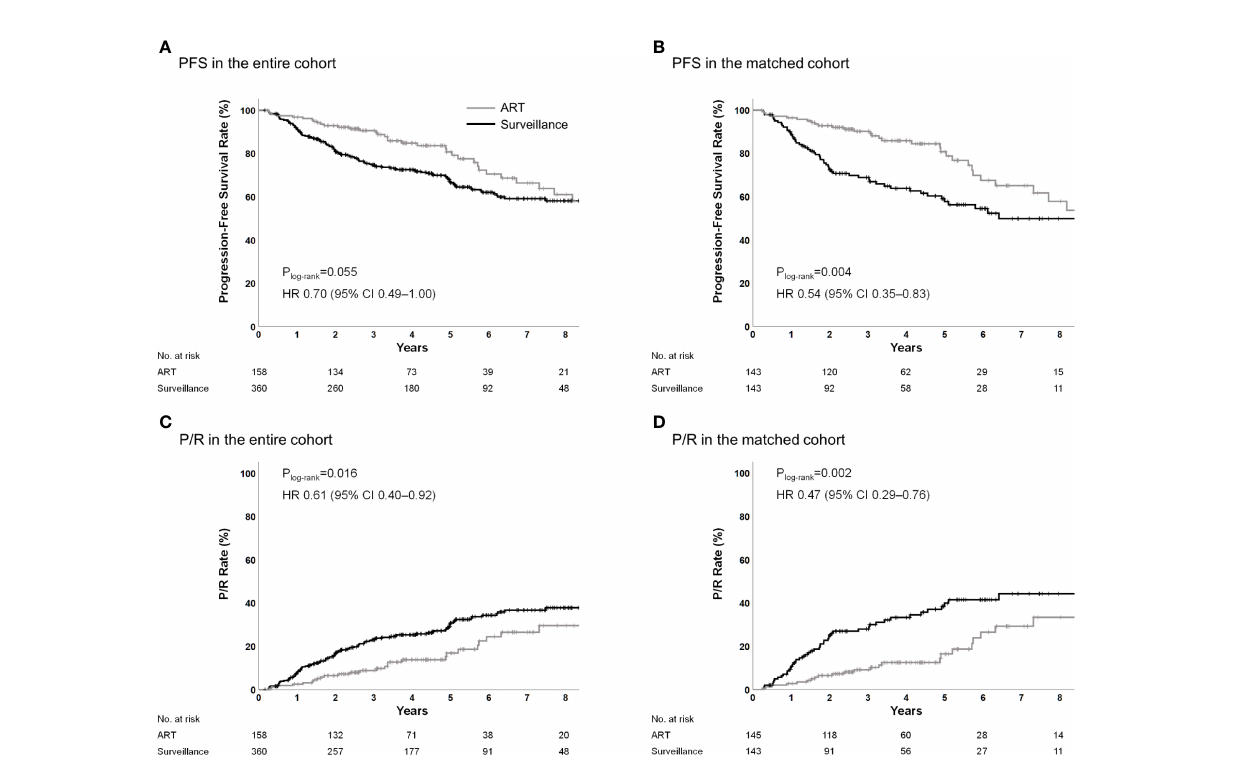
FIGURE 1 | PFS and P/R in the entire and propensity score-matched cohorts. ART, adjuvant radiotherapy; PFS, progression-free survival; P/R,